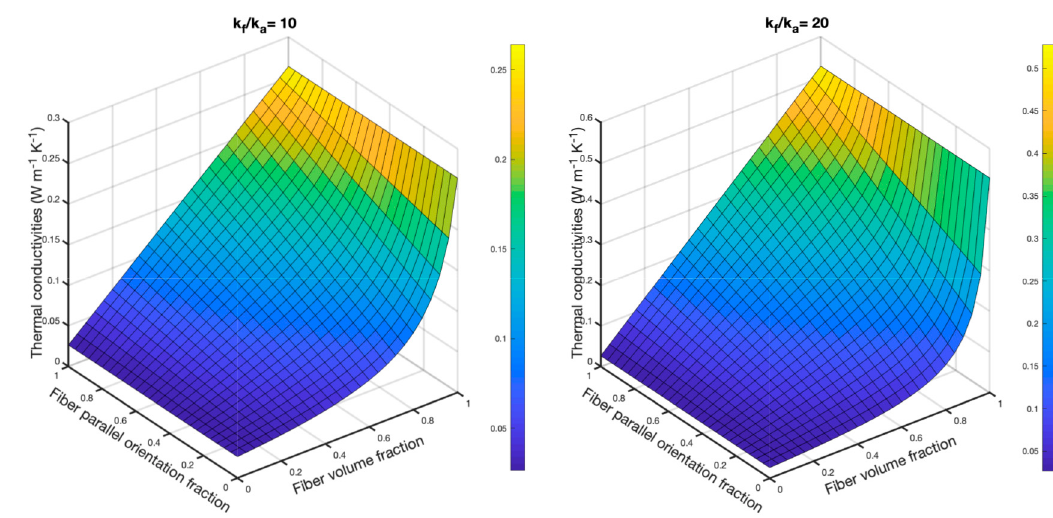
Figure 10. The effect of fiber orientation and fiber volume fractions on the thermal conductivity of nonwoven samples based on the Bogaty model. Table 8. Measured thermal conductivities of the nonwoven